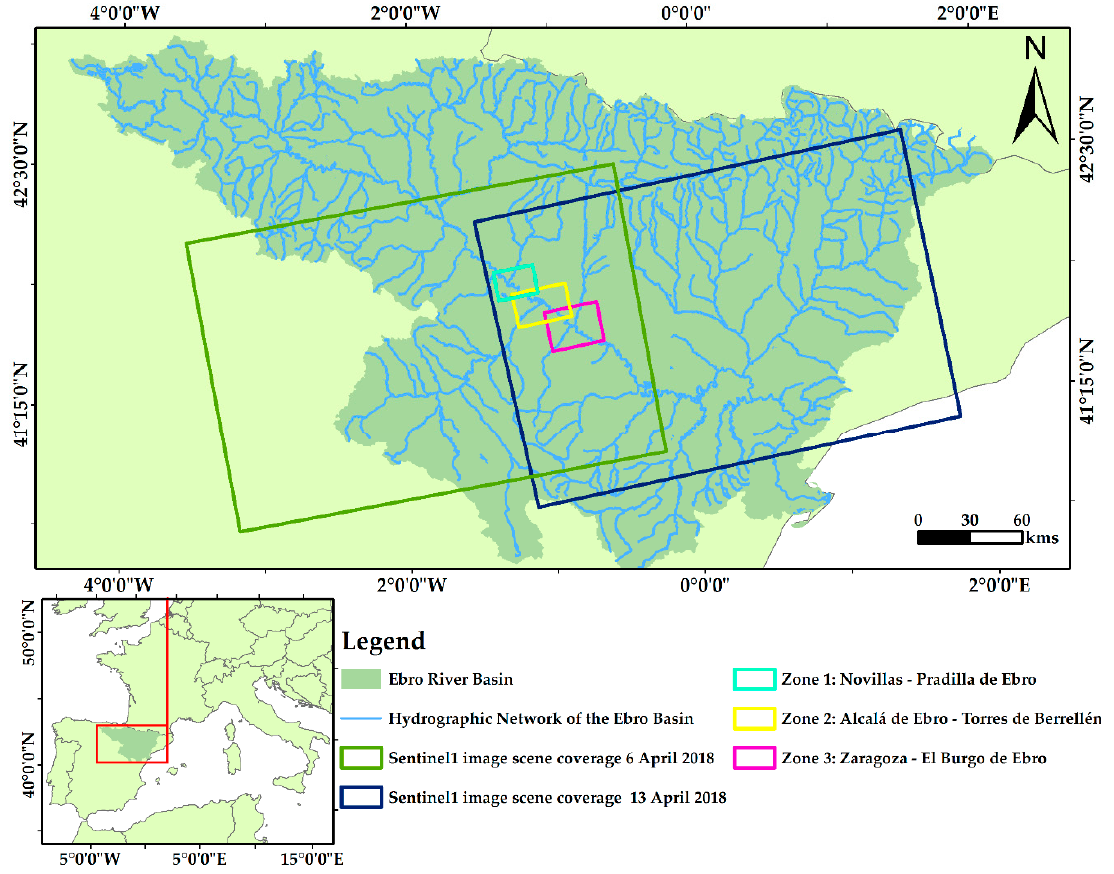
Figure 1. Location map and study areas.